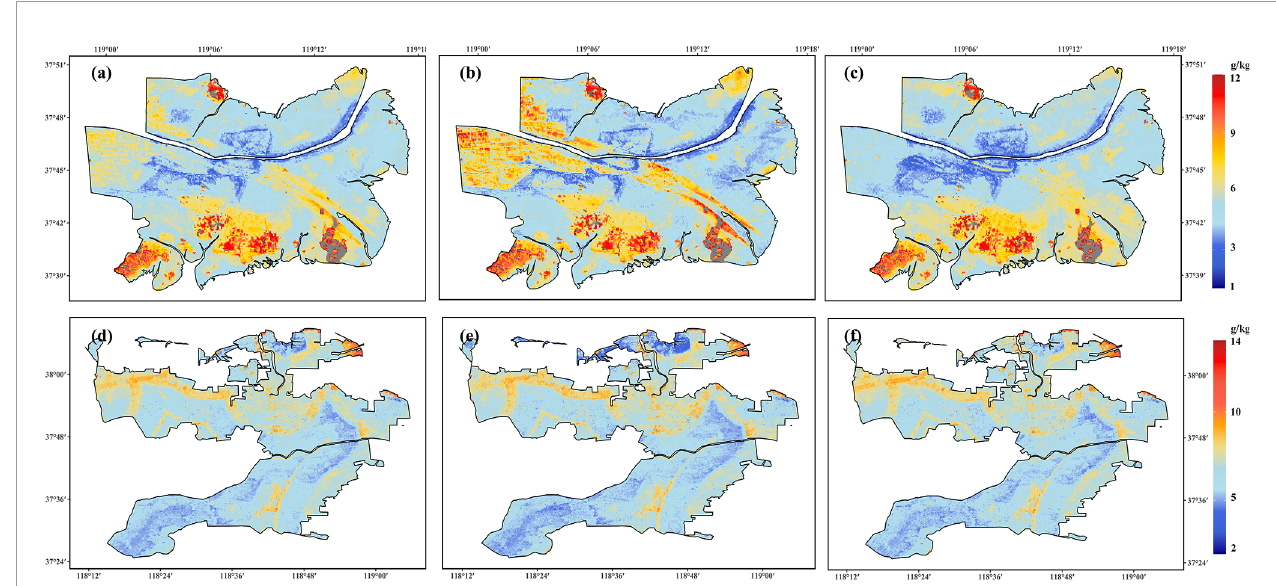
FIGURE 6 | Spatial distribution of the estimated mean salinity from 2006 to 2018 in (A) the nature reserves (NR) all year round, (B) the NR in warm seasons (from May to October), (C) the NR in cold seasons (from November to April), (D) the industrial and agricultural areas (IAA) all year round, (E) the IAA in warm seasons (from May to October), and (F) the IAA in cold seasons (from November to April).